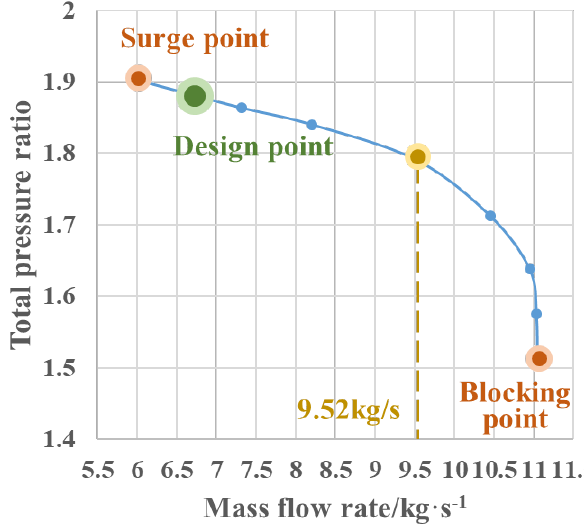
Figure 20. The compressor mass flow rate-total pressure ratio curve.